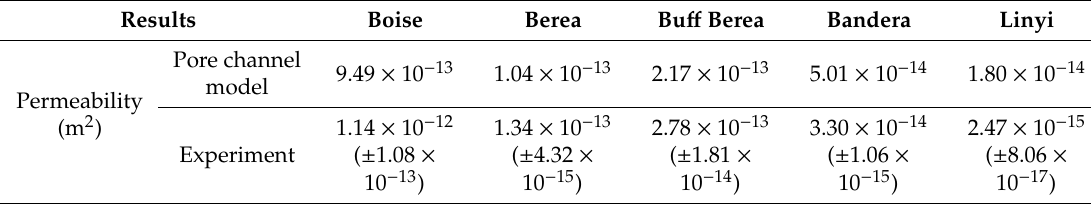
Table 7. Comparison of modeled and experimental permeability of each